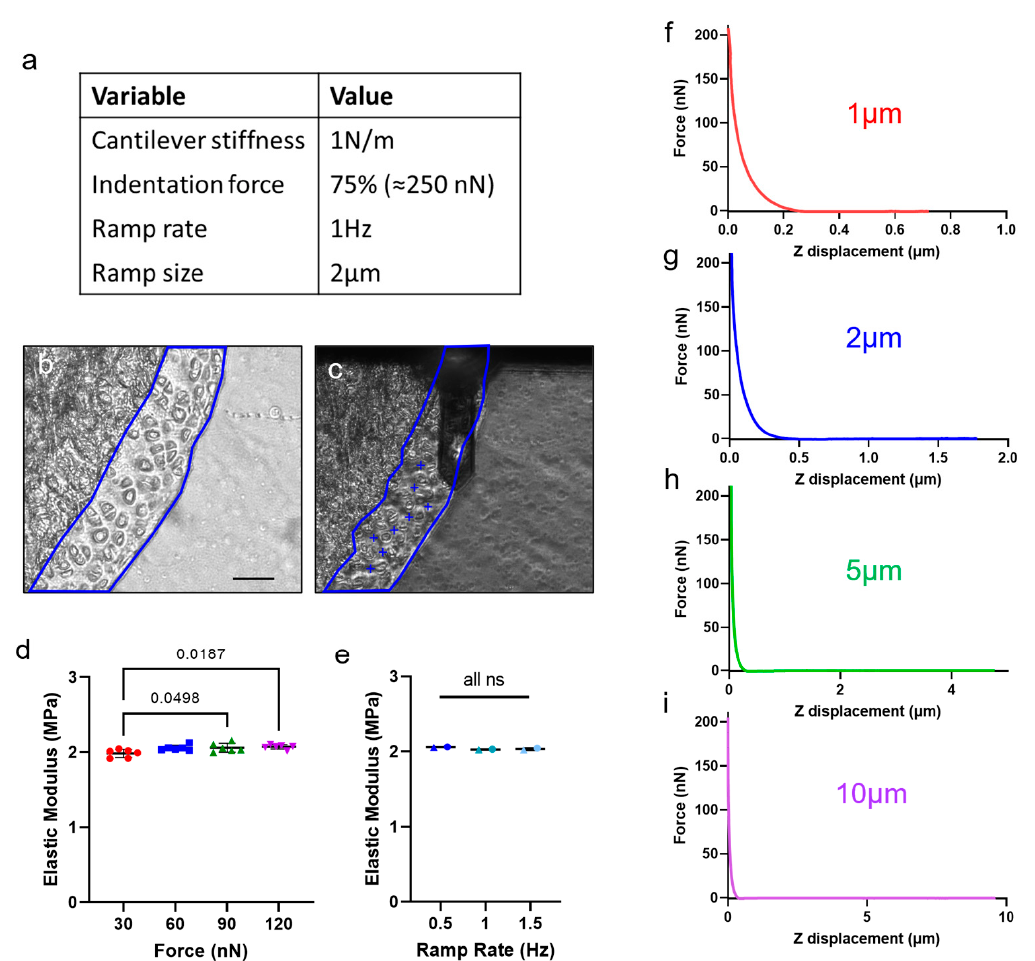
Figure 6. Parameter variation on murine articular cartilage. Sequential sections from medial distal femurs of two 12 week old C57BL/6J female mice were analyzed. ( a ) Area of articular cartilage to be indented (blue outline). Scale bar = 40 µm. ( b ) Same area showing example of indentation points (+) and visualization of the AFM tip and cantilever (black). ( c ) Effect of force on measured modulus. A slight increase in modulus was observed with higher indentation forces. Ramp rate = 1 Hz, ramp size = 2 µm, cantilever stiffness listed = 1 N/m. Colors indicate different indentation forces. ( d ) Effect of ramp rate on measured modulus. Ramp size = 2 µm, indentation force = 90 nN, cantilever stiffness listed = 1 N/m. Colors indicate different ramp rates. ns = non-significant ( p > 0.05). ( e – h ) The effect of ramp size on articular cartilage is very similar to that on PDMS. Loss of data resolution makes large ramp sizes particularly difficult to analyze. Given the slope at the contact point, 2 µm ensures adequate “zero” data to establish baseline. Ramp rate = 1 Hz, indentation force = 90 nN, cantilever stiffness listed = 1 N/m. ( i ) Final parameters chosen for AFM of articular cartilage in future experi- ments.